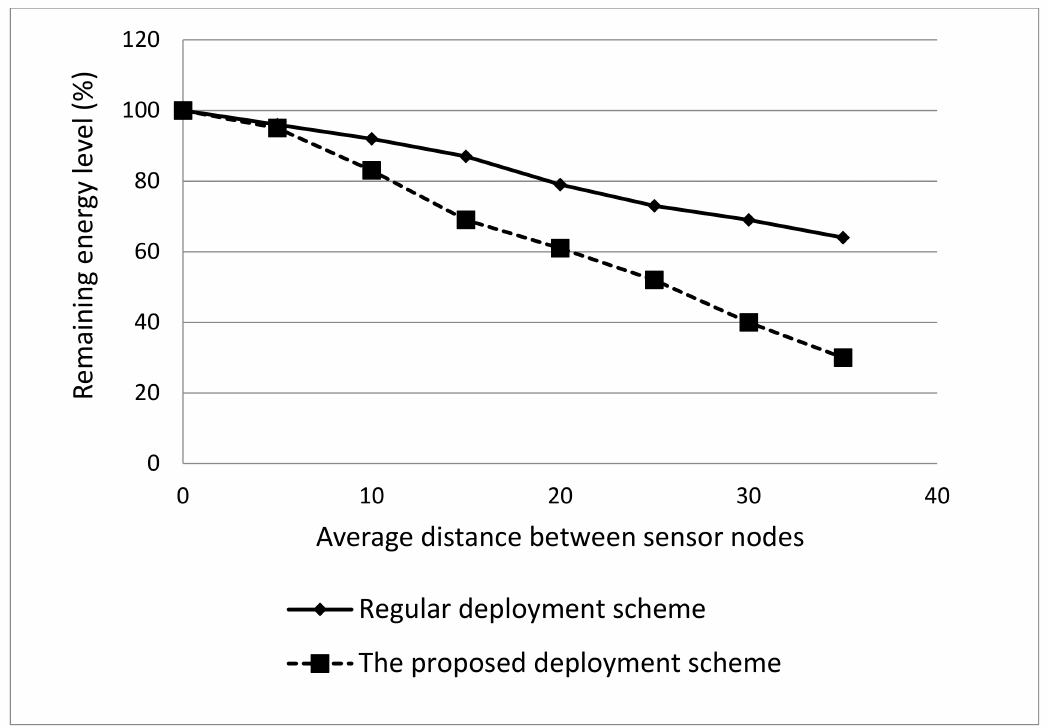
Figure 2. Remaining energy level of regular deployment and the proposed deployment schemes.